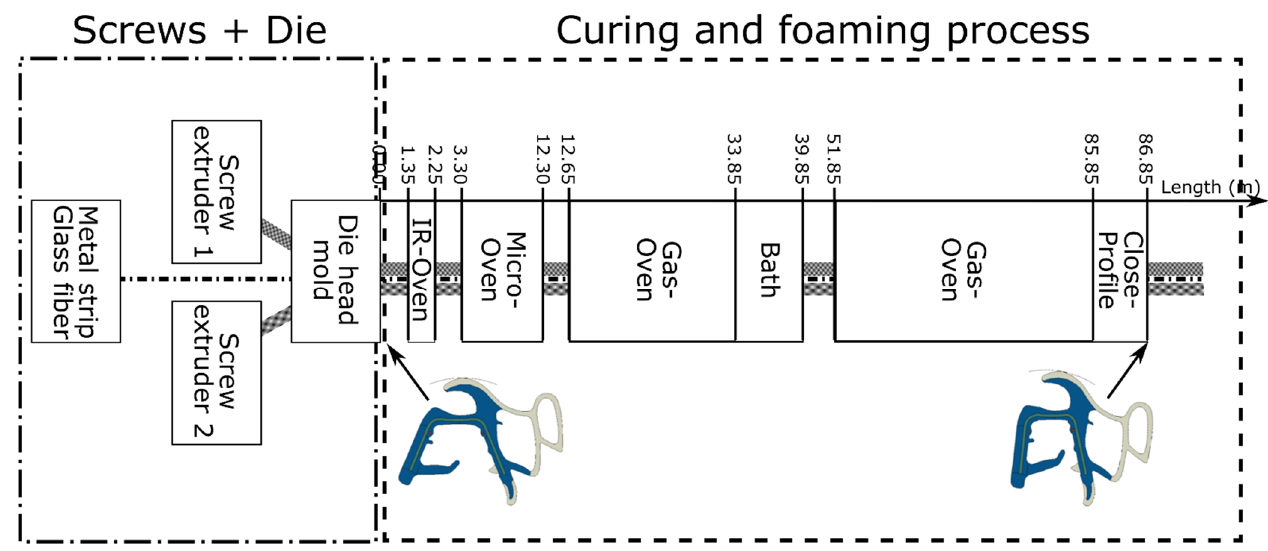
Figure 2. Scheme of the manufacturing process for the automotive door seal.